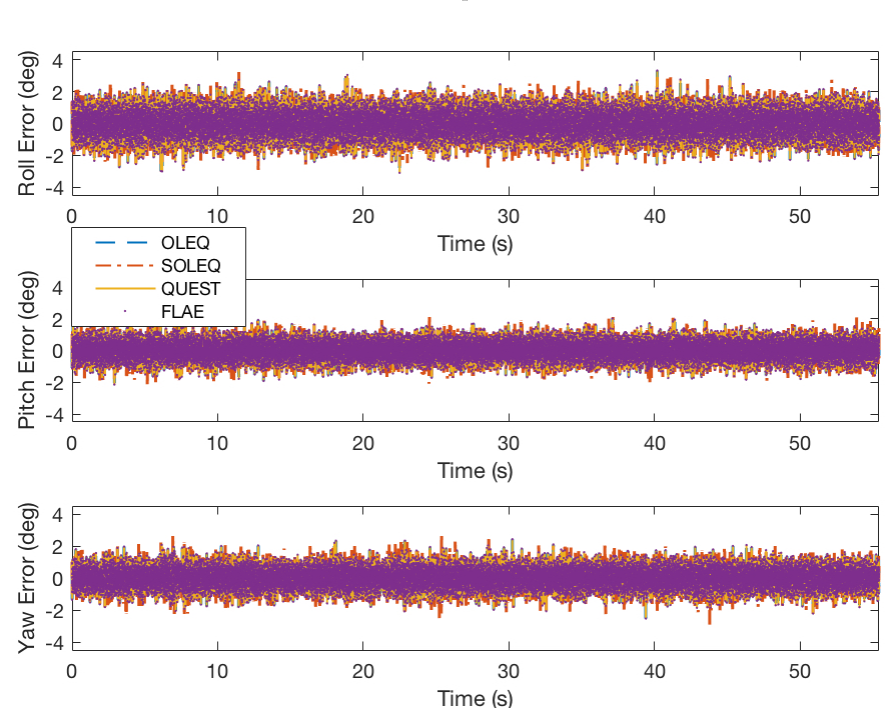
Figure 4. Experiment results of OLEQ, SOLEQ and representative algorithms using sampled data and different